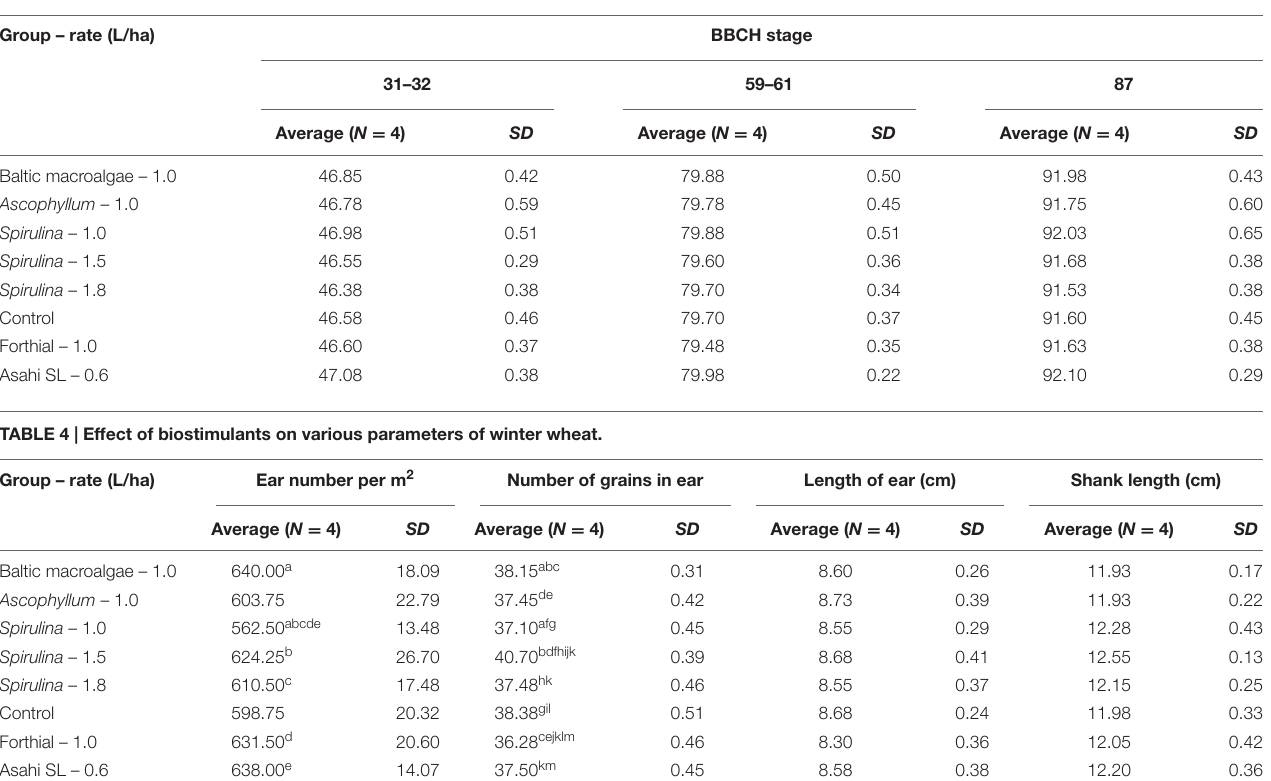
TABLE 3 | Crop height (cm) at different BBCH crop growth stages.